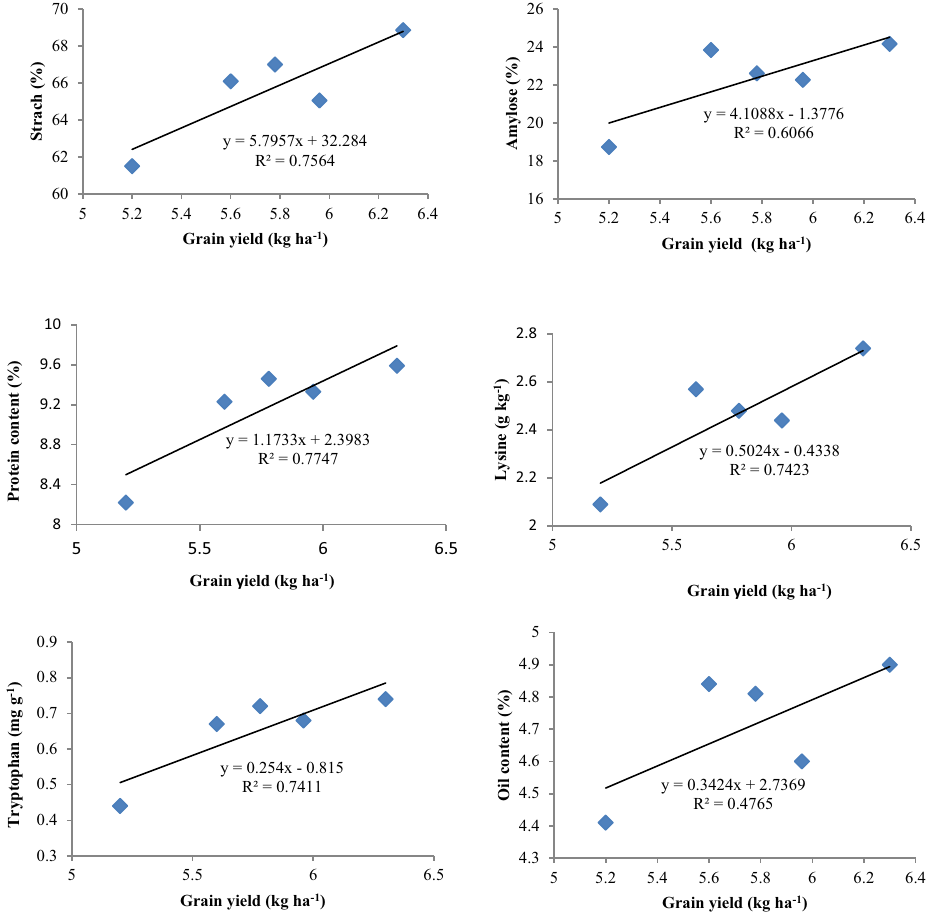
Figure 6. Correlation between grain yield and quality parameters of maize under P-fertilization practices in maize under